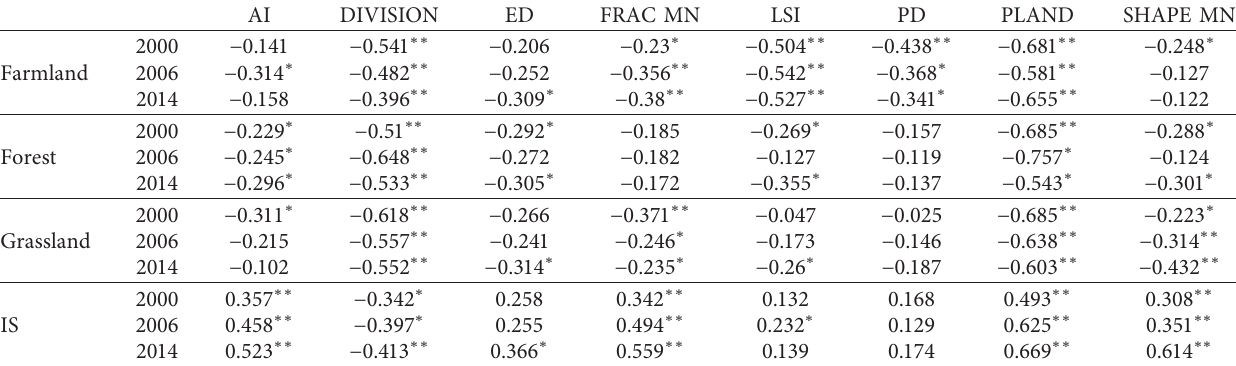
Table 7: Correlation coefficients between class-level metrics and LST.